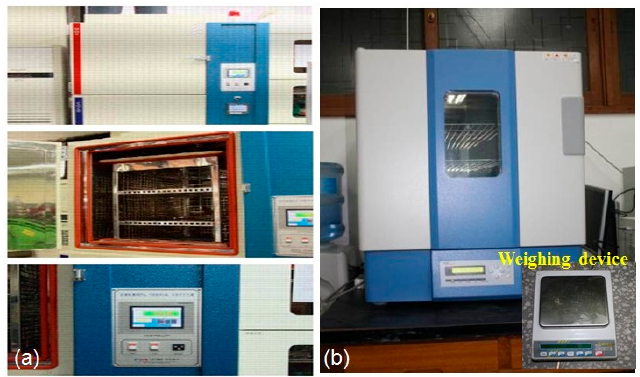
Figure 4. Instruments of temperature-humidity chamber ( a ) for thermal fatigue ( b ) for moisture diffusion.